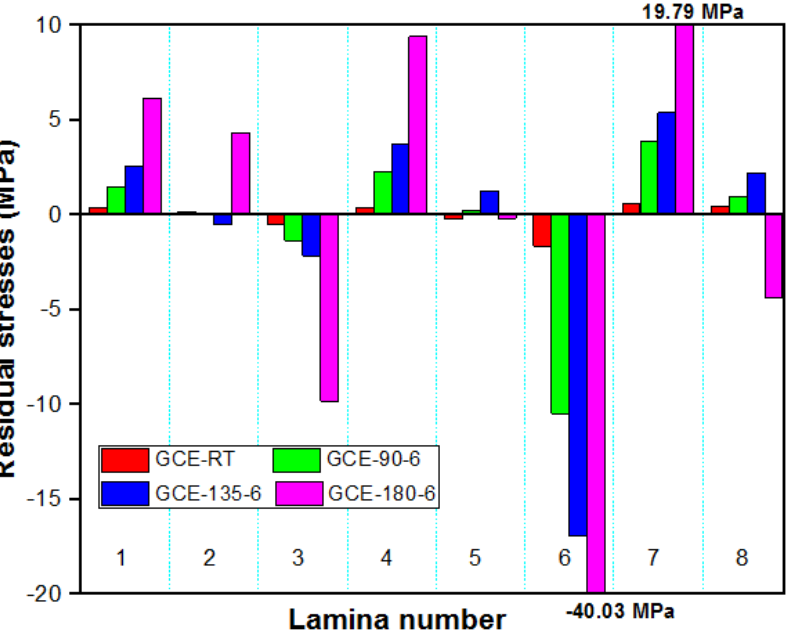
Figure 7. Transverse residual stress in each lamina determined from recorded transverse strains for all GCE laminates.